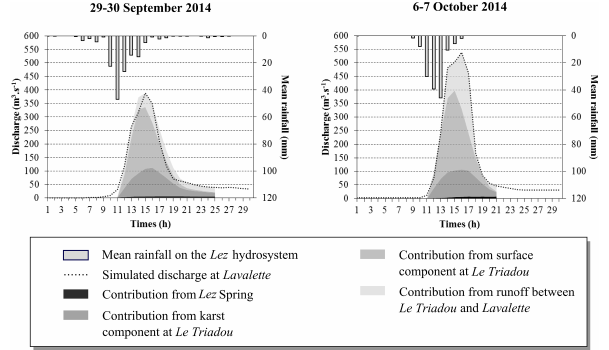
Figure 5. Karst and surface contributions to the discharge at Lavalette